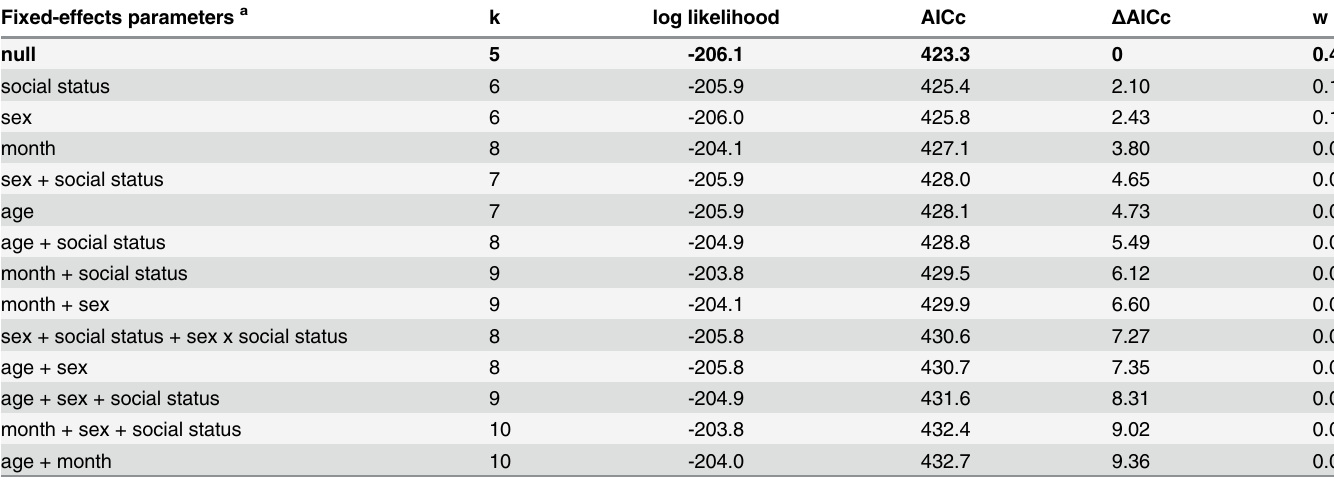
Table 4. Results of selection of mixed-models exploring the effect of sex, age, social status, and month on fecal cortisol metabolites levels in two wolf packs from Yellowstone National Park (USA), 2007 – 2009. Only candidate models with Δ AICc < 10 are shown. Fixed-effects parameters